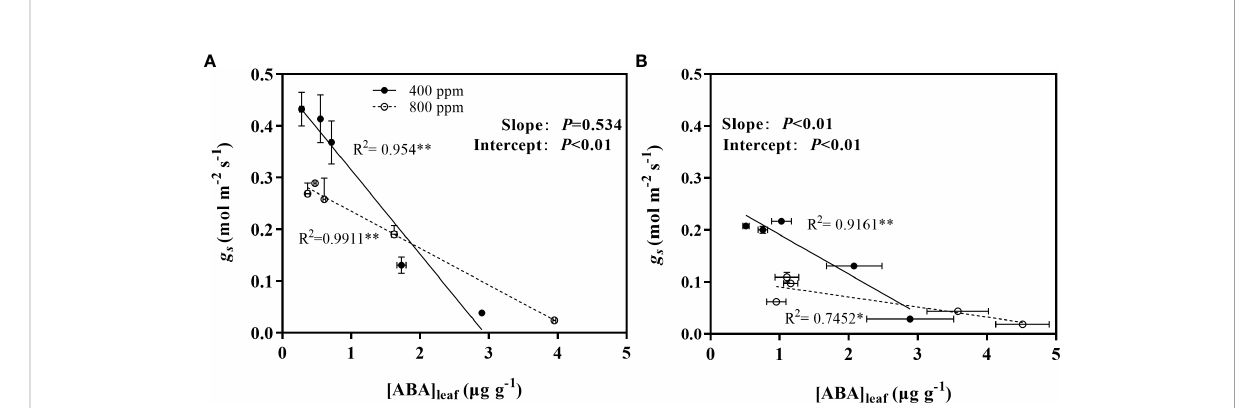
FIGURE 8 Relations between leaf ABA concentration ([ABA]leaf) with stomatal conductance ( g s )of wheat (A) and maize (B) plants grown under ambient (400 ppm) and elevated (800 ppm) atmospheric CO 2 concentrations during progressive soil drying. Error bars indicate standard error of the means (SE) (n =